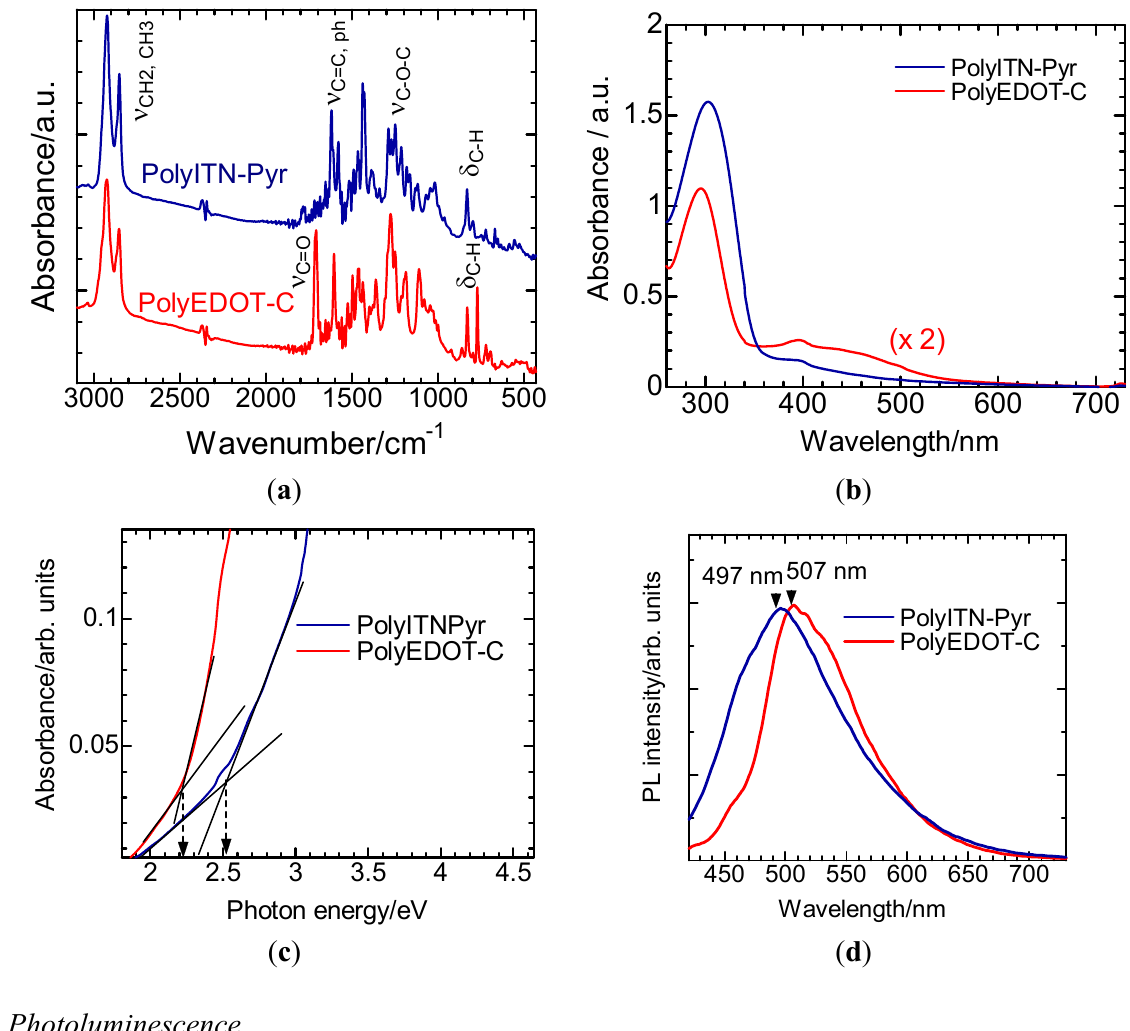
Figure 3. ( a ) FT-IR spectra of the polymers; ( b ) UV-vis optical absorption spectra of the polymers; ( c ) Absorbance as a function of photon energy; ( d ) Photoluminescence